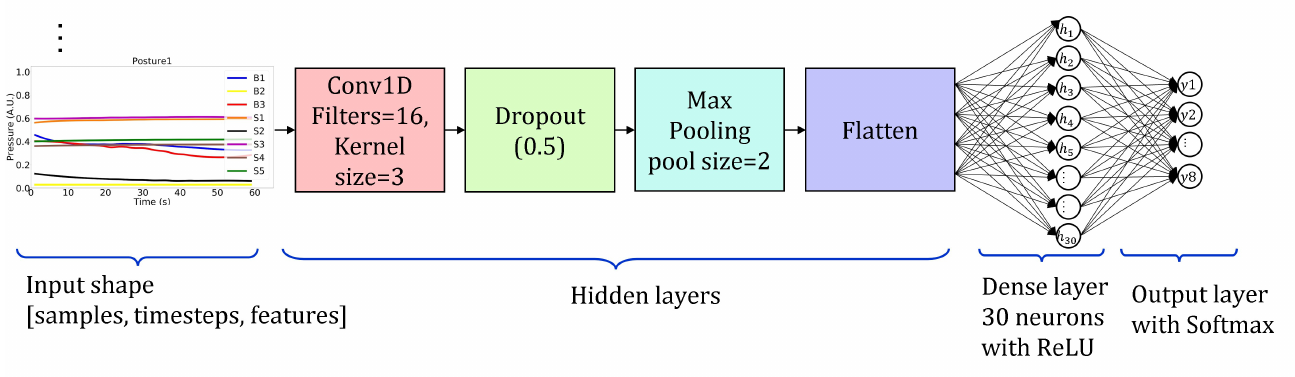
Figure 7. The adopted CNN model architecture. Input has a 3D shape. Hidden layers are Conv1D with 16 filters, dropout, Max pooling, flatten, and dense layer with 30 neurons. The output layer has 8 neurons for 8 postures